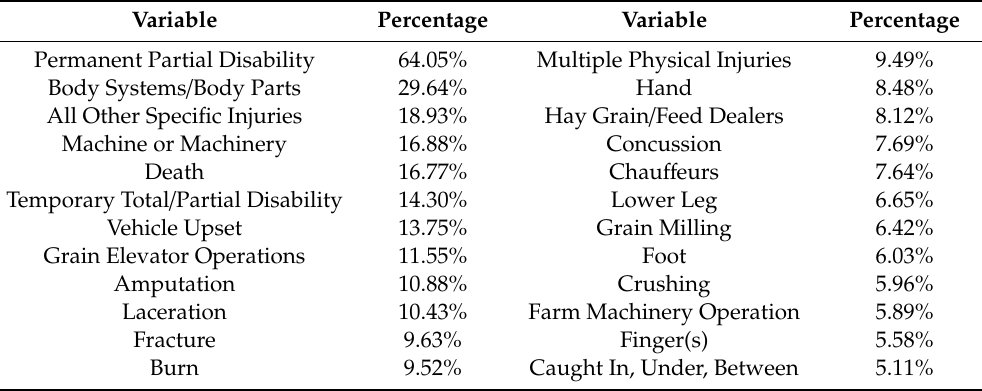
Table 7. Characteristics of injury patterns in class 3.